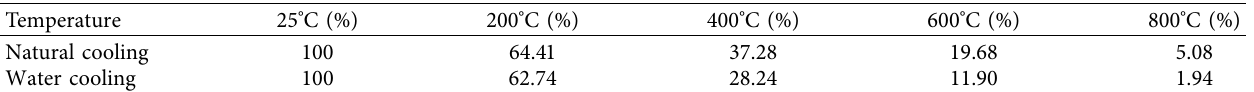
Table 8: Peak stress rate of change with